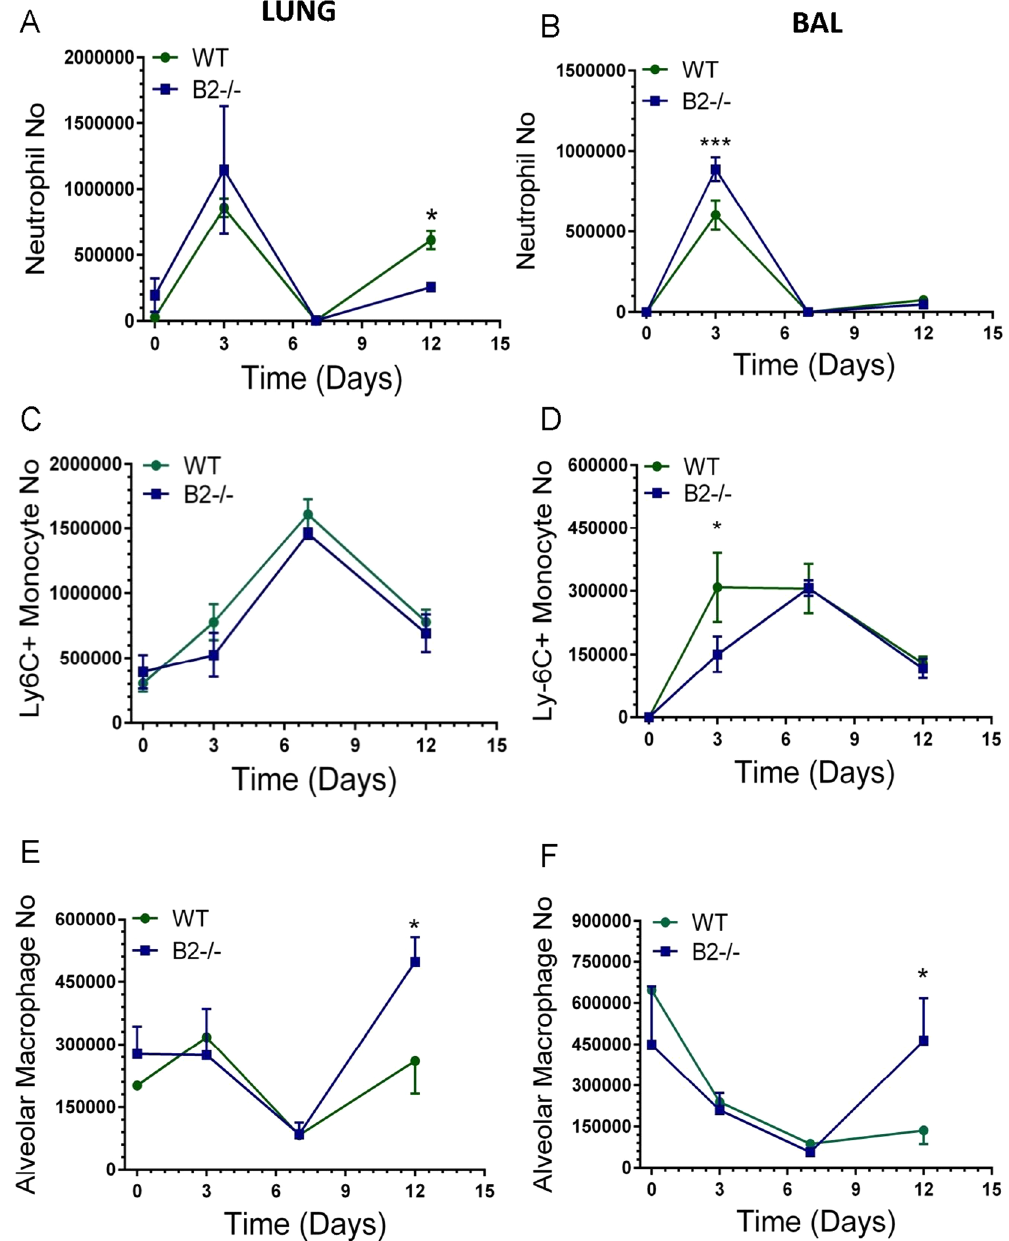
Figure 6. Endophilin B2 shapes inflammatory cell recruitment and suppresses recovery of AMs after IAV infection. The number of neutrophils, Ly-6C + monocytes, and AMs in lungs ( A, C, E ) and BAL ( B, D, F ), respectively, was determined by flow cytometry. Significant differences in the number of cell types between WT and B2 − / − mice were calculated for ( A ) * p < 0.02 at day 12, ( B ) * p < 0.01 at day 3, ( D ) * p < 0.0002 at day 12, ( E ) * p < 0.007 at day 3, and ( F ) * p < 0.02 at day 12. (n = 3 mice per group at t = 0, 3, and 7, and n = 12 at t = 12. The data on day 12 are pooled from three independent